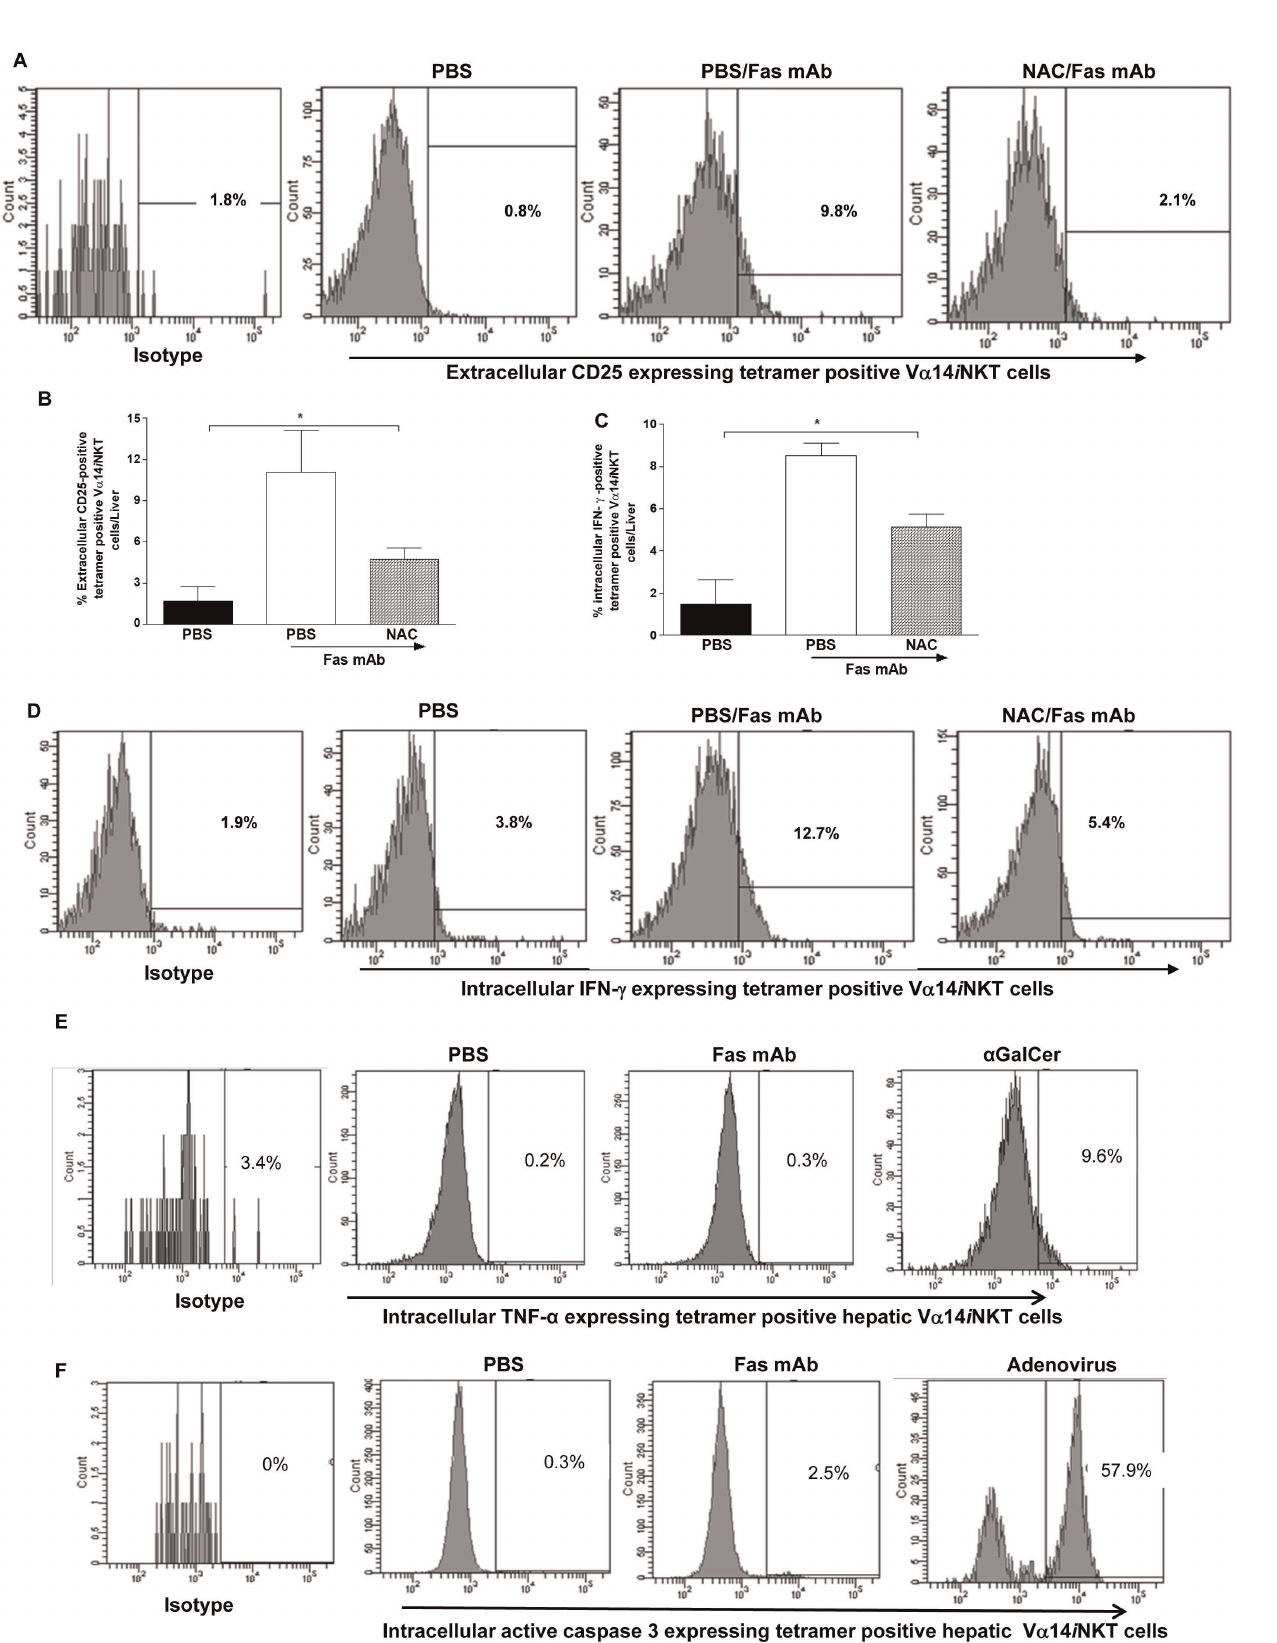
Figure 2. Effect of NAC treatment on intrahepatic V a 14 i NKT cell activation during agonistic Fas mAb-induced FLF. Representative FACS histograms of extracellular CD25 ( a ), intracellular IFN- c ( d ), intracellular TNF- a ( e; a Galcer used as a positive control) and intracellular active